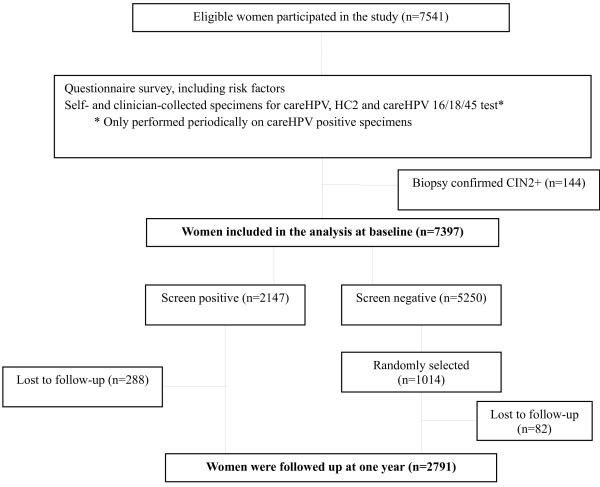
Flowchart of inclusion and exclusion of the study participants. At baseline, 144 women were excluded because of biopsy confirmed CIN2+, with 7397 women in the baseline analysis. 288 of the 2147 baseline screen positives were lost to follow-up and 82 of the 1014 randomly selected baseline screen negatives were lost to follow-up, which added up to 2791 women in the follow-up analysis. CIN2+:cervical intraepithelial neoplasia grade 2 or above.